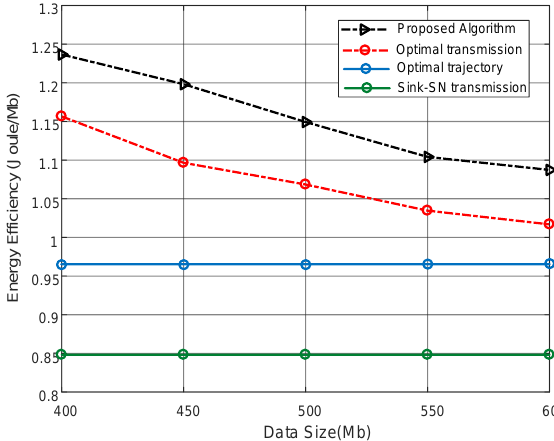
Figure 3. Energy efficiency comparison under different transmission deadlines with file size S n = 400 Mbits.